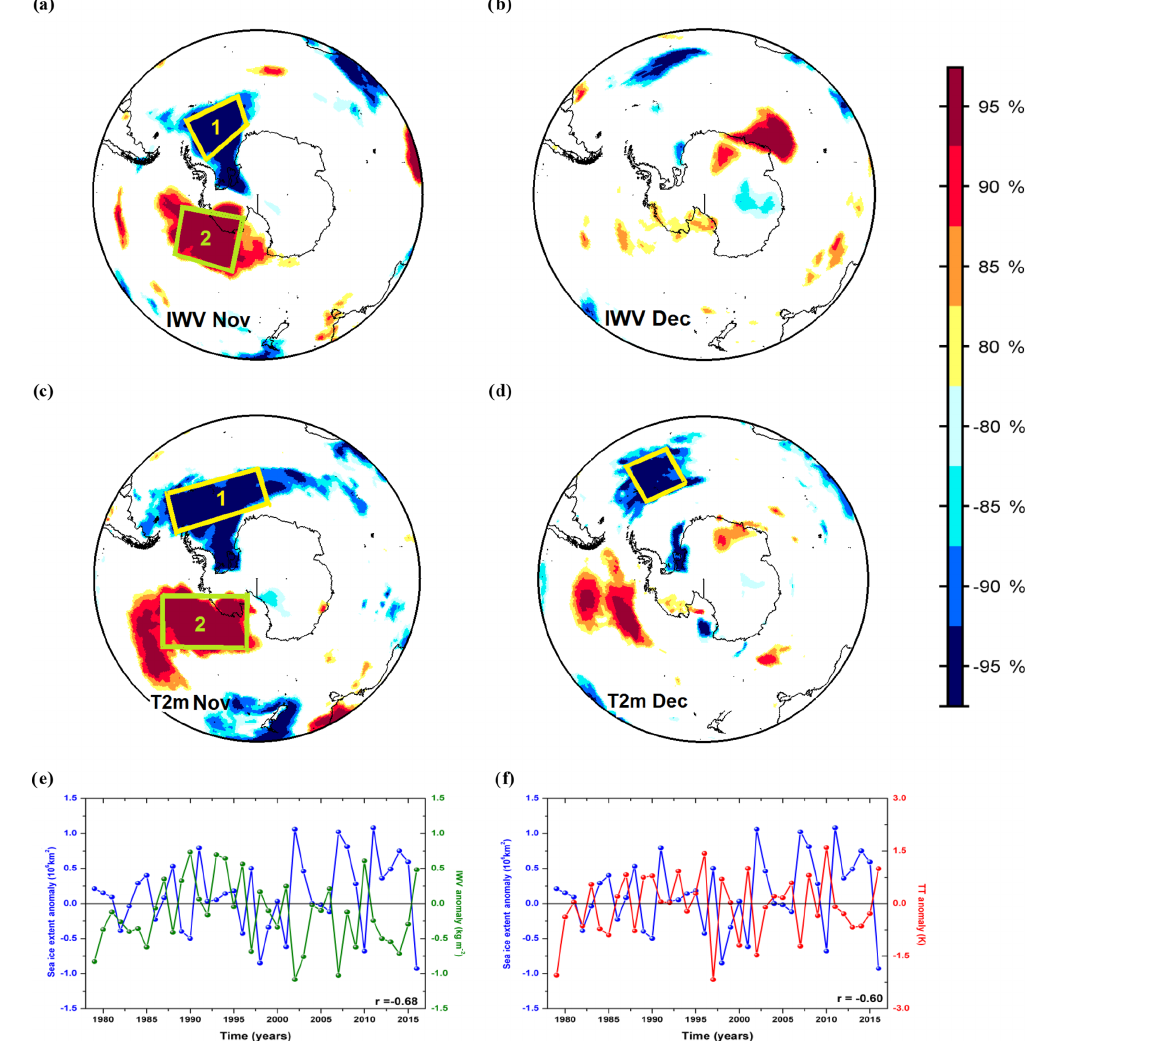
Figure 8. The stability maps between December Weddell Sea (WS) sea ice extent and (a) November IWV, (b) December IWV, (c) November T2m, and (d) December T2m. (e) The time series of December WS SIE (blue line) and the time series of November IWV1 (green line) averaged over the region shown in the yellow box in (a) ; (f) the time series of December WS SIE (blue line) and the time series of November T2m1 (red line) averaged over the region shown in the yellow box in (b) . The regions where the correlation is positive and stable are represented as dark red (95% significance level), red (90% significance level), orange (85% significance level), and yellow (80% significance level) and the regions where the correlation between the regional SIE index and the gridded data is stable and negative will be represented as dark blue (95% significance level), blue (90% significance level), green (85% significance level), and light green (80% significance level) on the stability